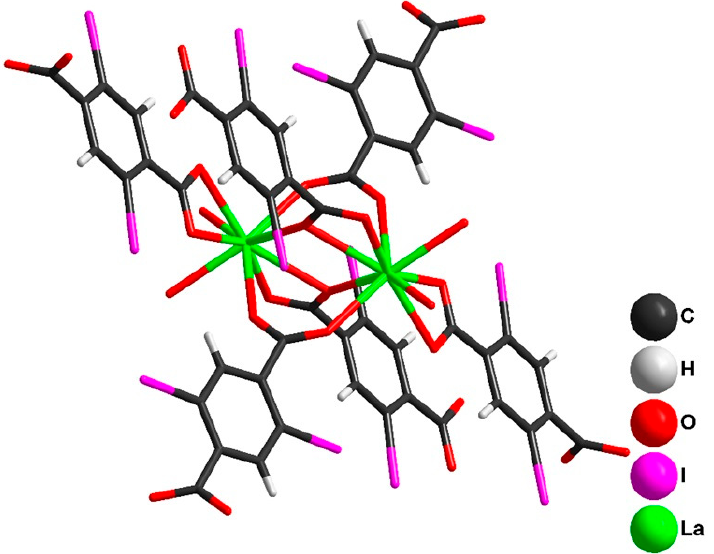
Figure 1. Structure of [La 2 (2,5-I-bdc) 6 (DMF) 4 ] in the crystal structure of 1 . Disordered DMF molecules are omitted for clarity (only O-atoms are shown).